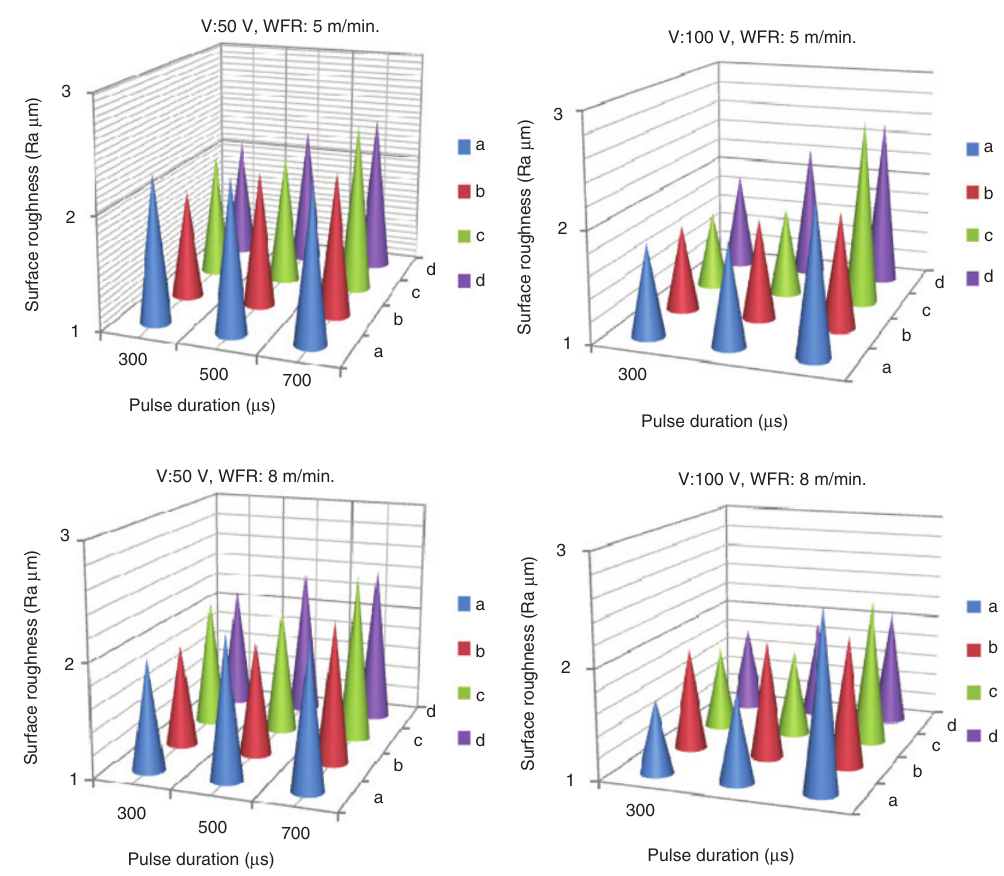
Figure 12 Surface roughness: pulse duration.